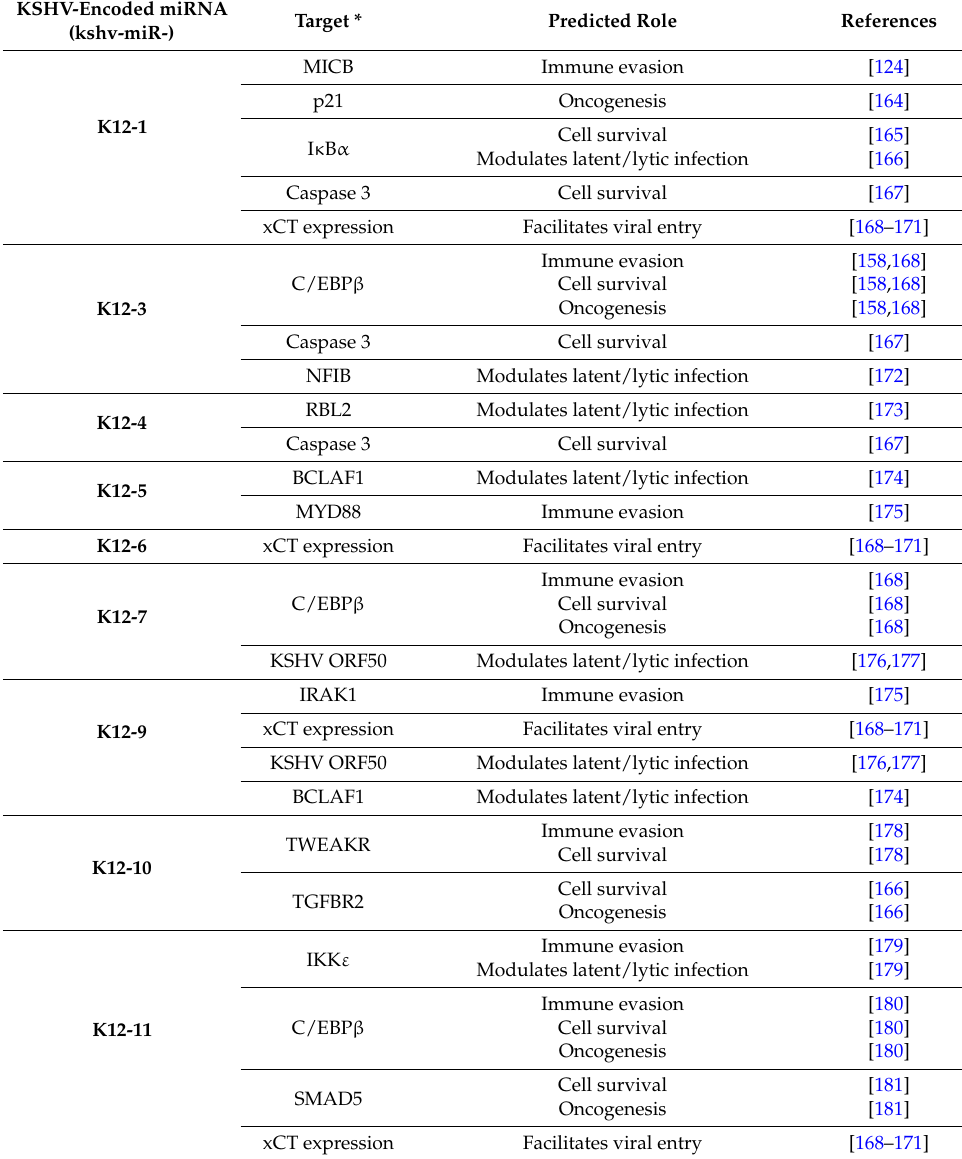
Table 2. MicroRNAs with potential role in KSHV infection and